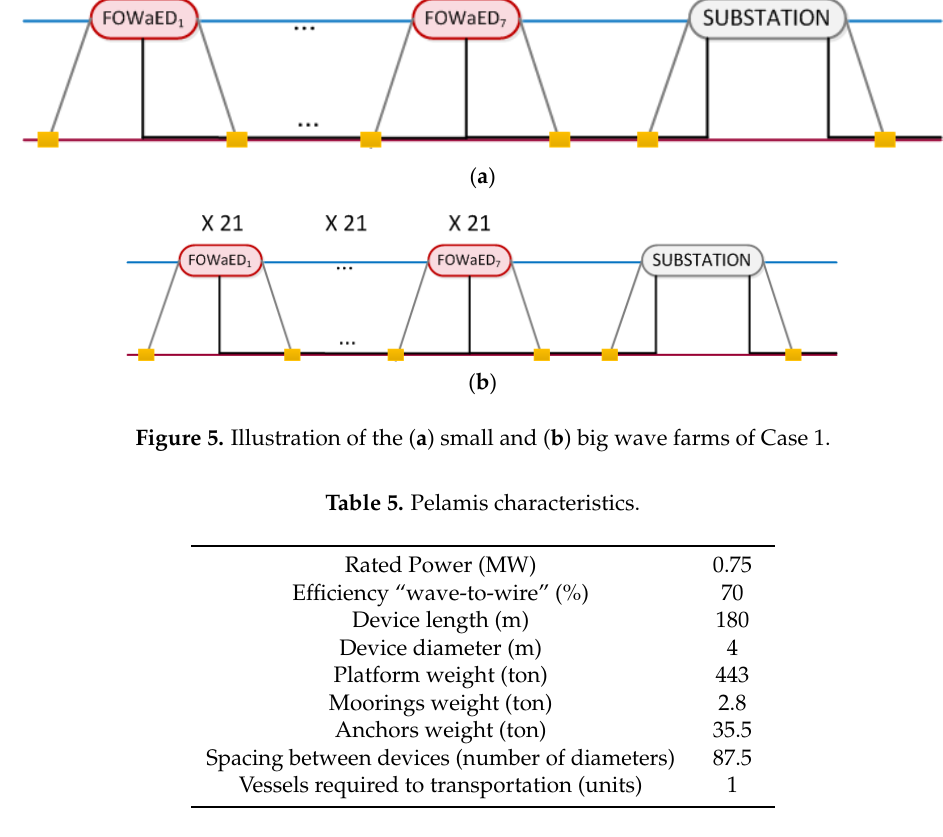
Figure 6. Illustration of the ( a ) single offshore wind turbine and ( b ) offshore wind farm of Case 2.